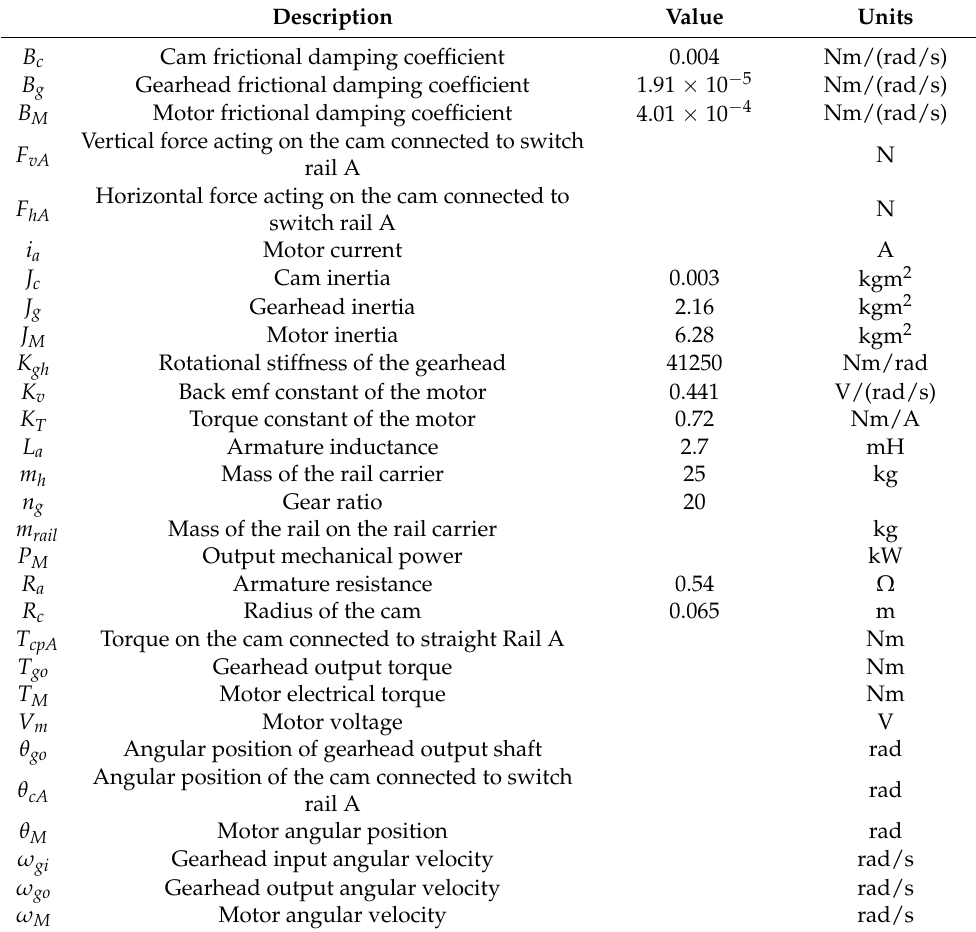
Table 1. Mathematical symbols used in the switch model and their